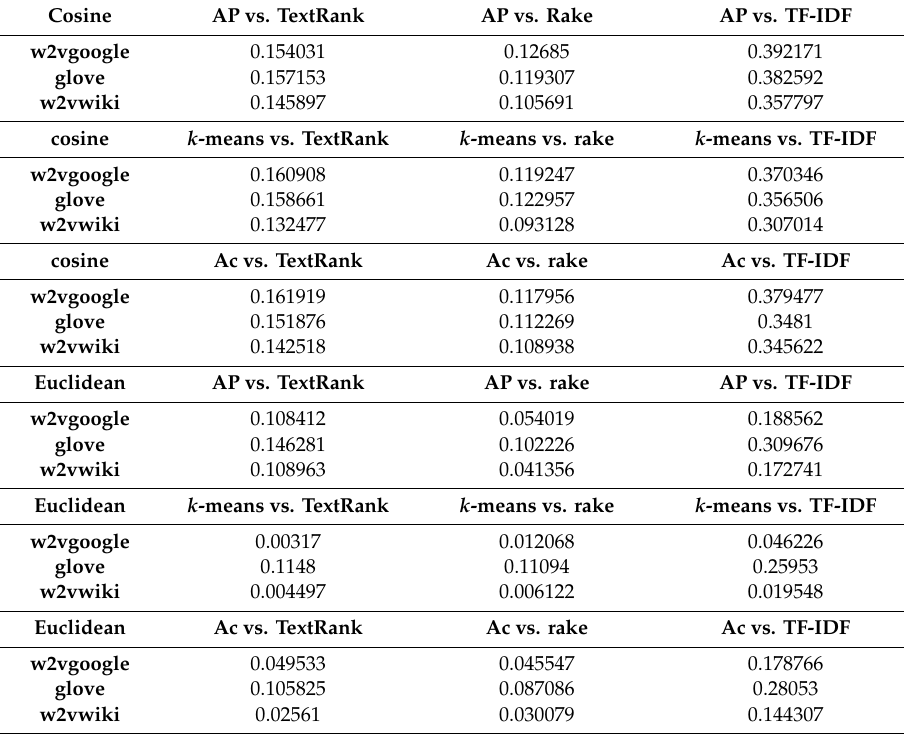
Table A3. SD coe ffi cients for baseline approaches and our method, on 1